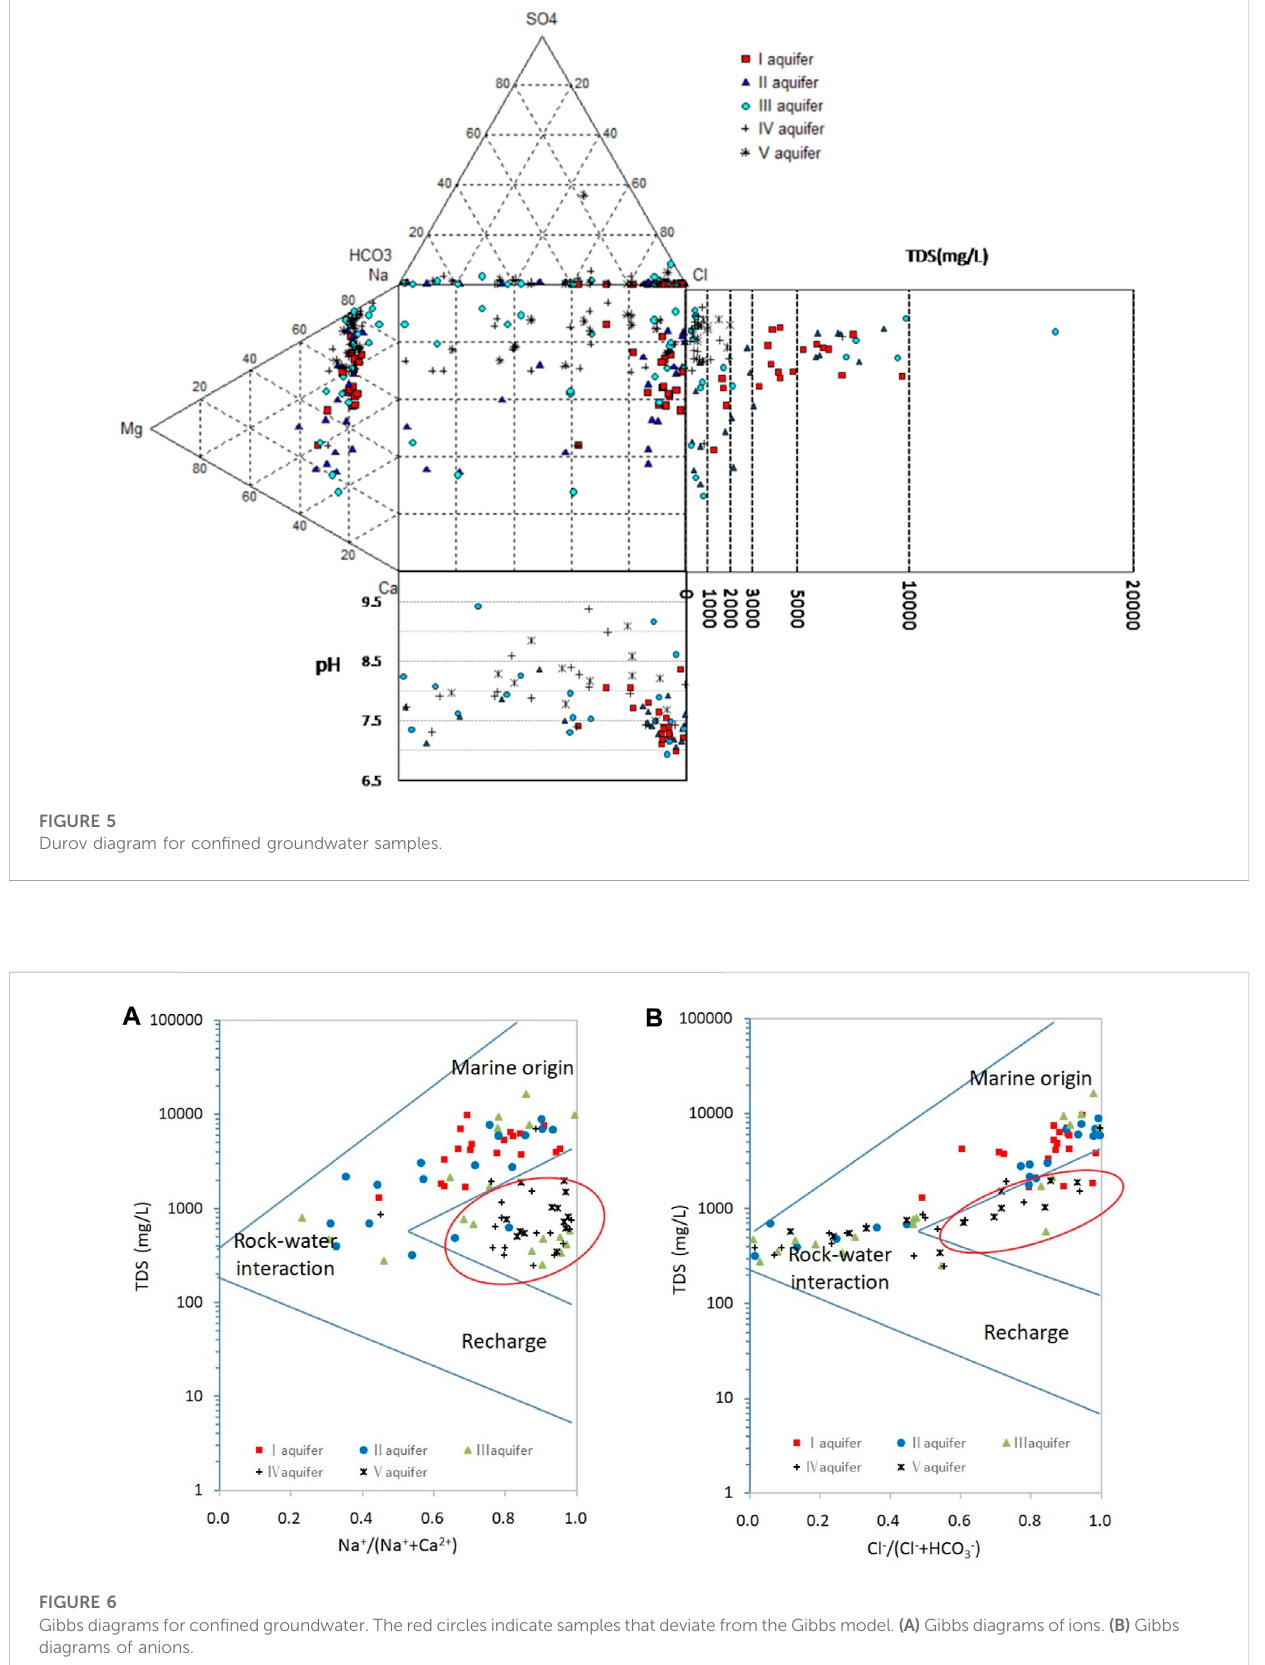
Frontiers in Earth